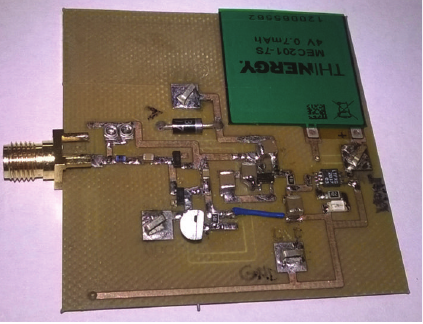
Figure 10: Prototype of the proposed power management circuit.